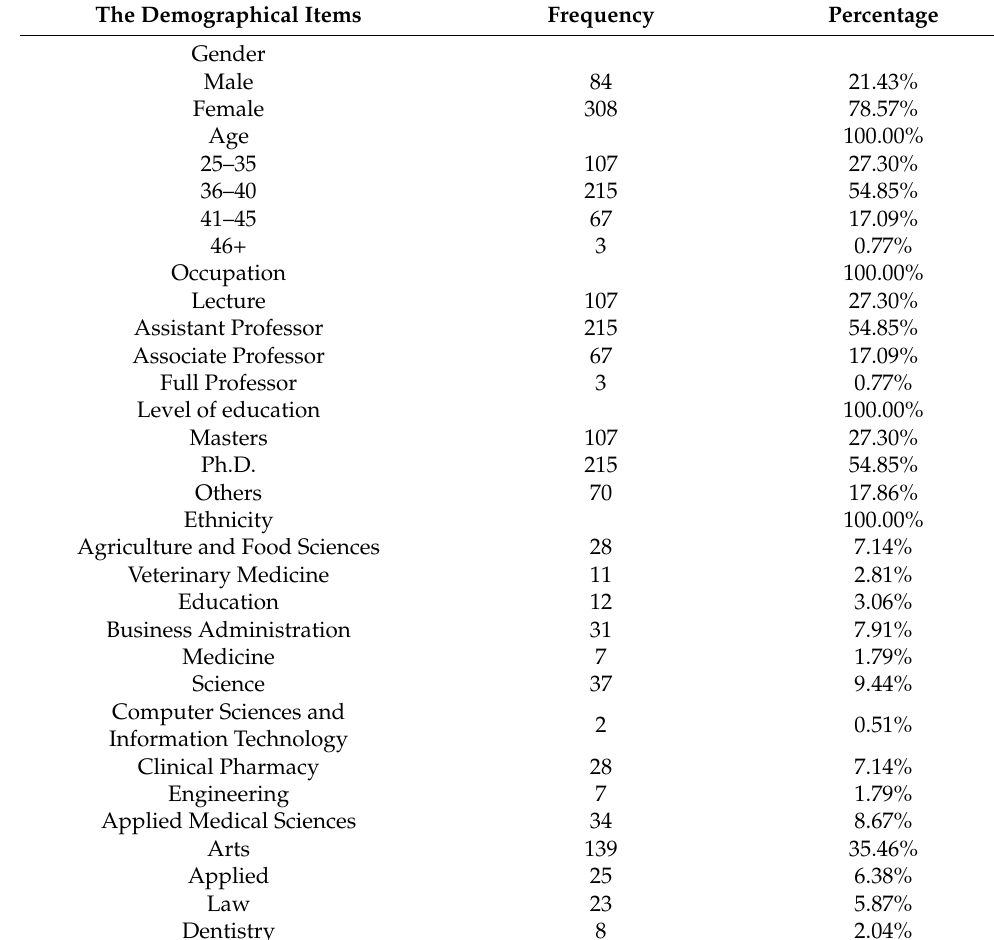
Table 2. Participants’ demographical characteristics.